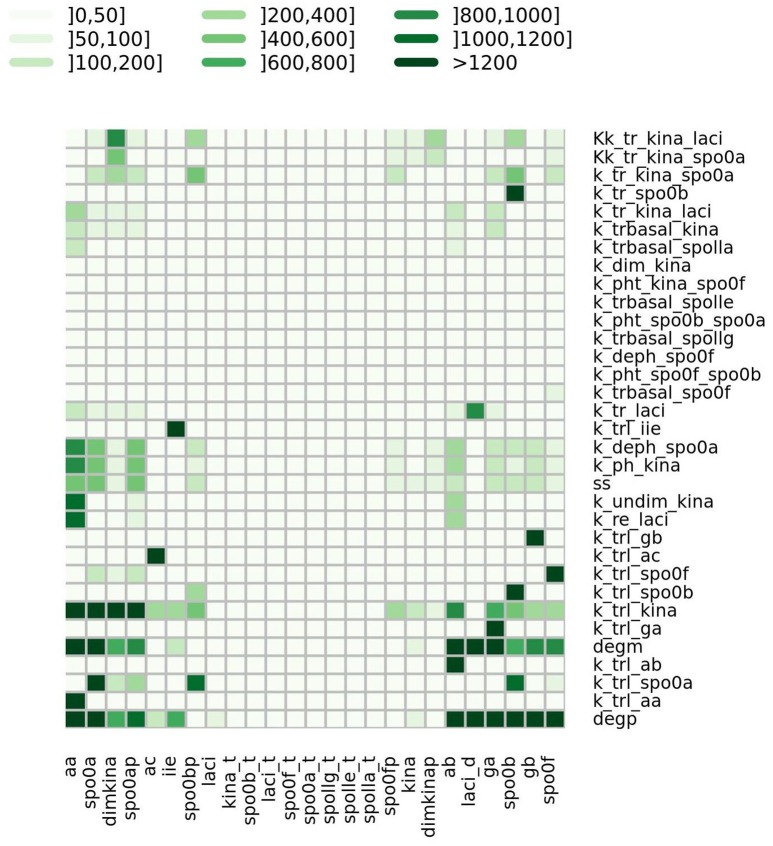
Heatmap summarizing the results of sensitivity analysis. The color of the cell is indicative of the value of the sensitivity index S as given in Equation (2), categorized by intervals.